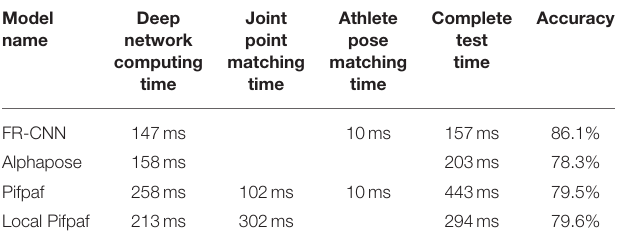
TABLE 2 | Performance comparison of the same Human Pose Estimation (HPE) algorithm.